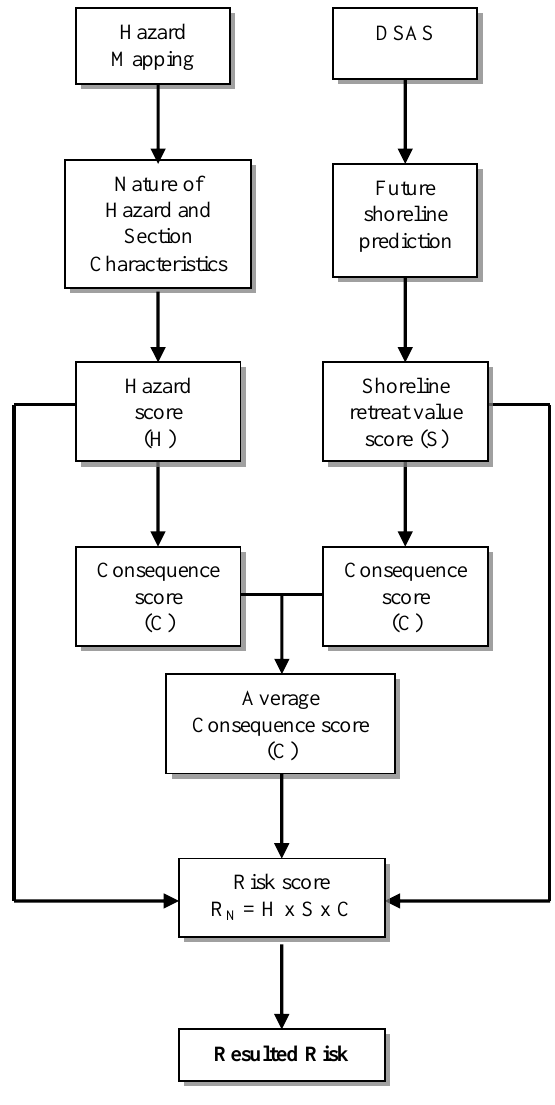
Fig.9. The procedure of Risk estimation Fig. 9. The procedure of Risk